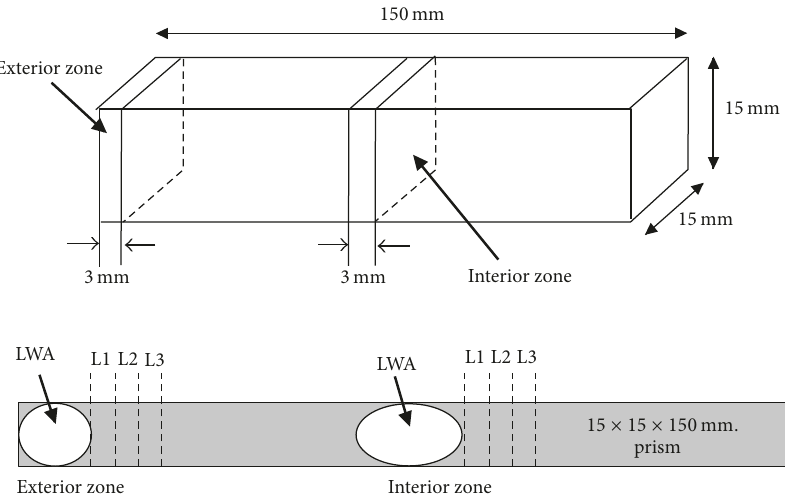
Figure 6: Cutting layout of 3 × 15 × 15 mm. layers (L1, L2, and L3).